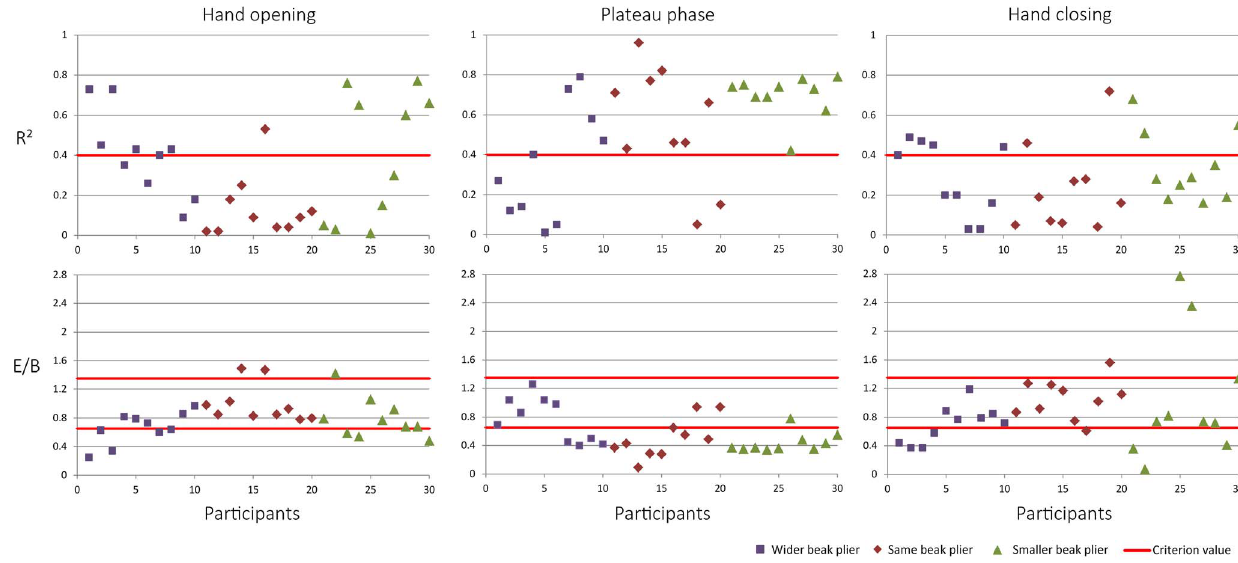
Figure 3. Data distribution of the R 2 and the ratio of improvement of all participants. The R 2 and the ratio of improvement are plotted for all participants for the variables hand opening, plateau phase and hand closing. The Wider Beak group is indicated by blue points, the Same Beak group by red points and the Smaller Beak group by green points. The red lines indicate the criterion values determined for the corresponding variable.